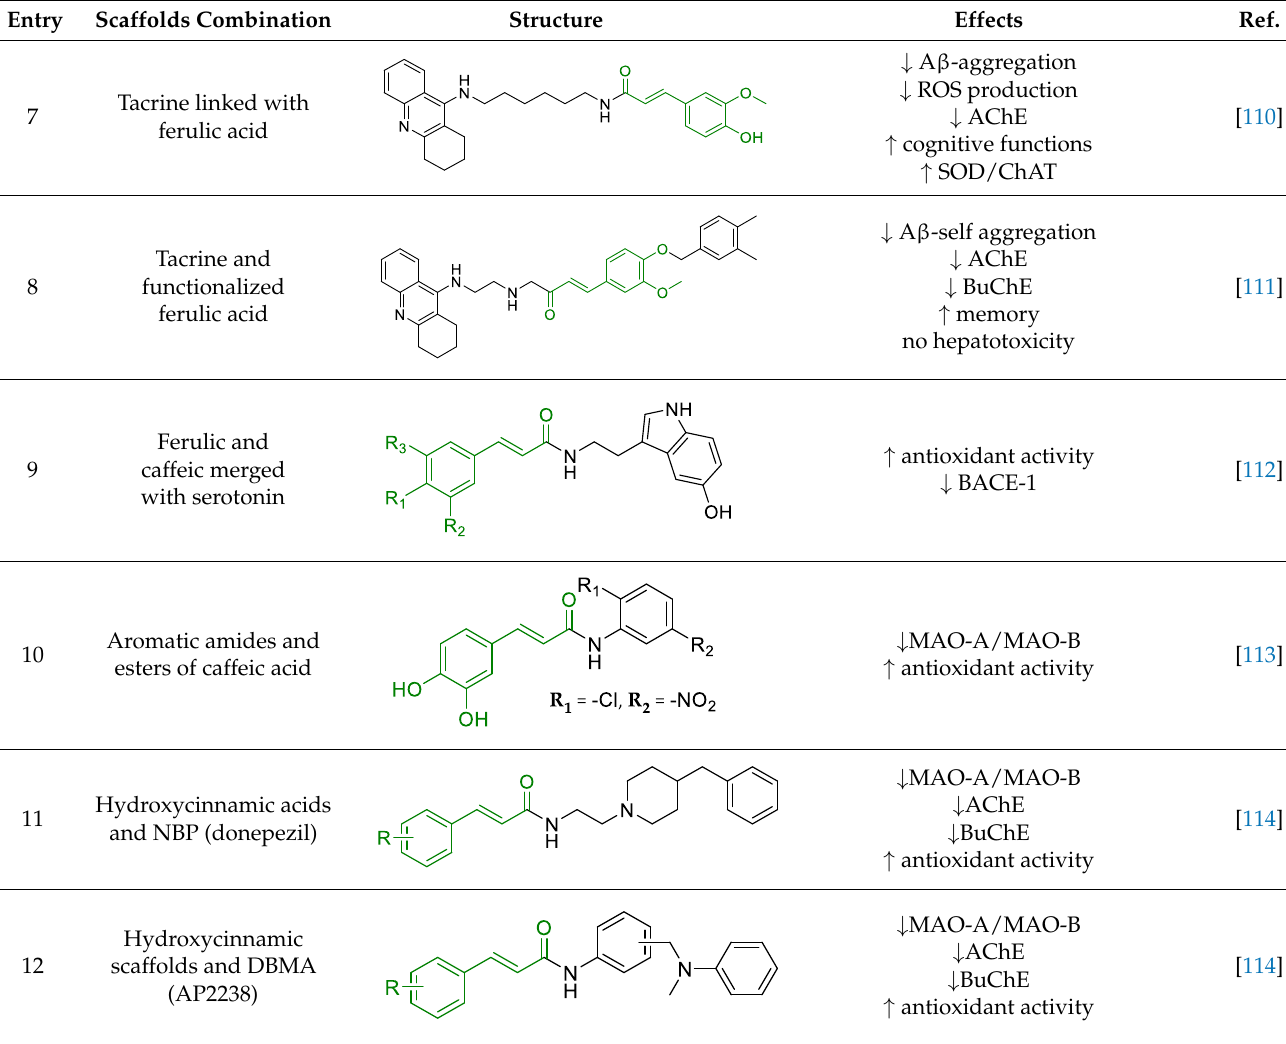
Table 3. Phenolic acids hybrids and their main biological effects.